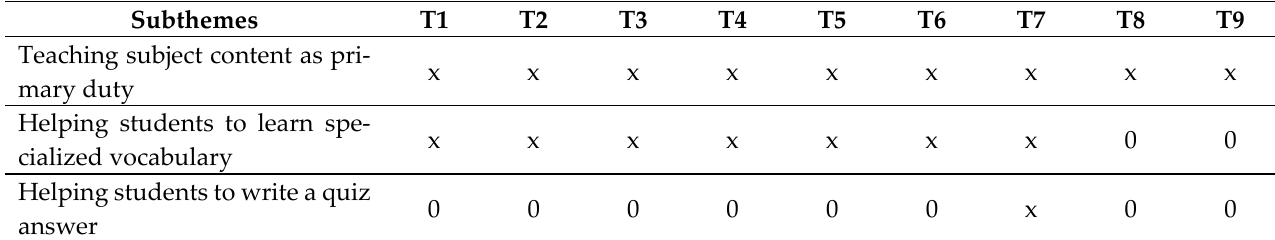
Table 3. Roles of EMI Teachers